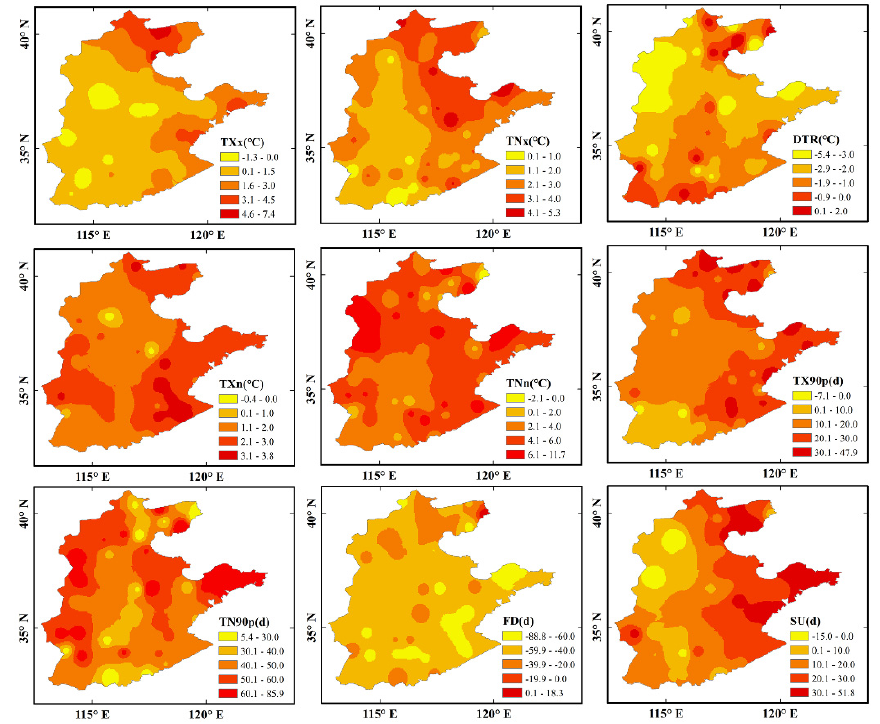
Figure 6. Spatial characteristics of changes in extreme temperature indices in the North China Plain from 2061 to 2100 under the SSP245 scenario.